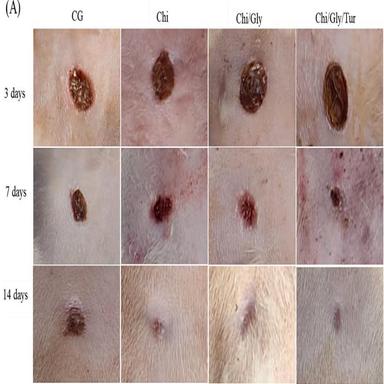
(A) Macroscopic evolution of wounds. (B) Wound repair quantitative evaluation.